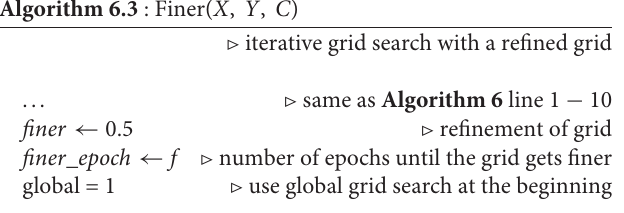
Algorithm 6.3 : Finer( X , Y , C